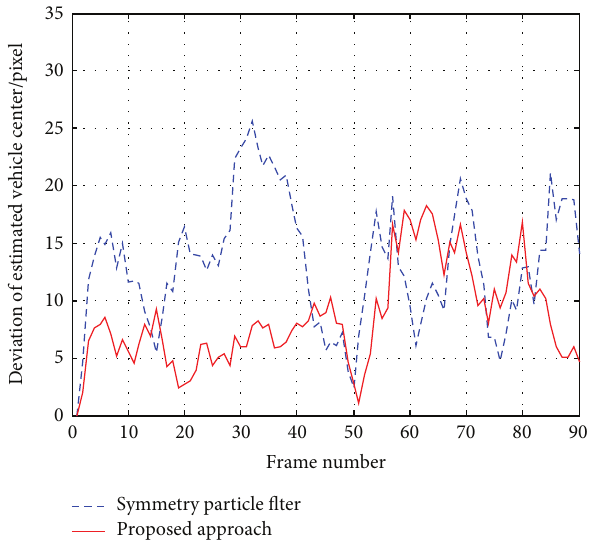
Figure 5: Deviation of estimated vehicle center.